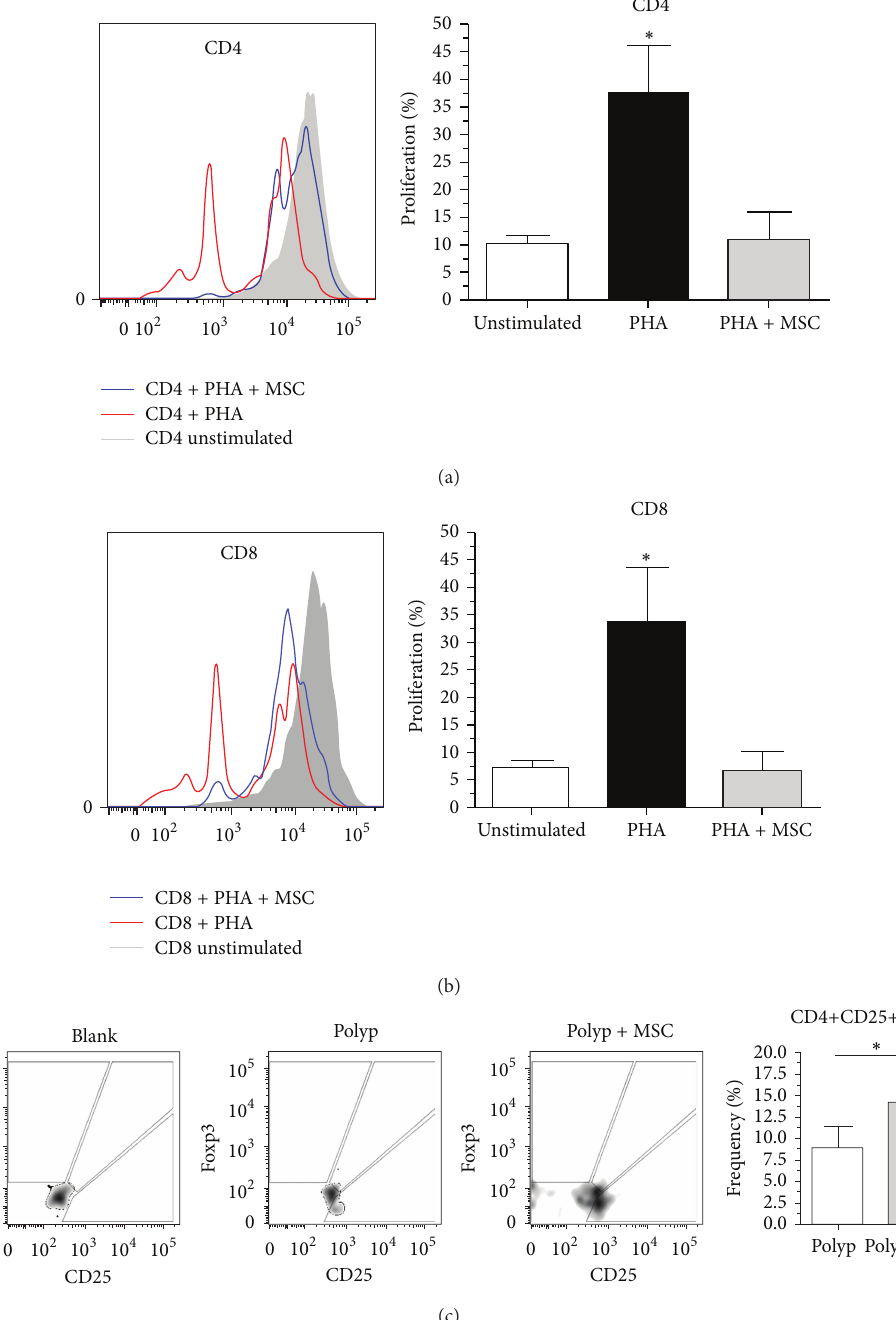
Figure 4: Bone marrow-derived mesenchymal stem cells exhibit functional immunosuppressive action on polyp-derived cells in vitro . (a, b) Proliferative index of CD4+ and CD8+ cells, respectively, stimulated with phytohemagglutinin (PHA), in the presence or absence of MSCs; (c) frequency of CD4+CD25+Fpxp3+ cells in the presence or absence of MSCs. Functionally, MSCs exhibited immunosuppressive action on polyp-derived cells, as represented by inhibition of proliferation of CD4+ and CD8+ cells with a concomitant increase in CD4+CD25+Fpxp3+